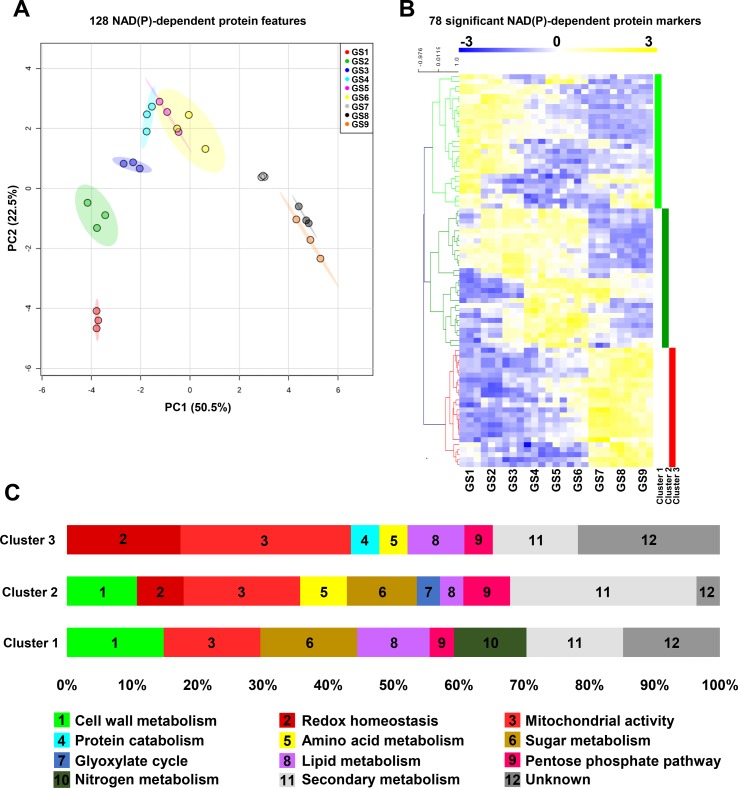
Protein profiles for NAD(P)-dependent enzymes unveil distinct clusters during tomato fruit growth. Normalized protein data 127 NAD(P)-dependent enzyme (see Materials and Methods) were visualized (A) for global impact of the growth stage of tomato fruit by principal component analysis (PCA with maximal variation given into brackets). Same features were then filtered (ANOVA with Bonferroni correction, P < 0.01) and subjected to clustering analysis (B) using MeV (http://mev.tm4.org/). Shown are Pearson’s correlations after complete clustering of 78 significant protein profiles. Four clusters were identified and analyzed for functional classification based on their gene ontology annotations (C). GS, growth stage.